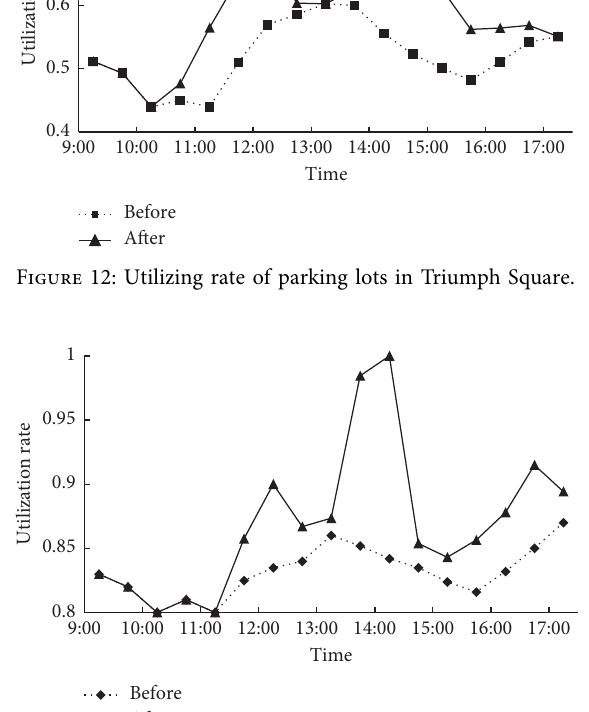
Figure 10: Total walking distance after parking from Song Lei Commercial Building to Triumph Square.